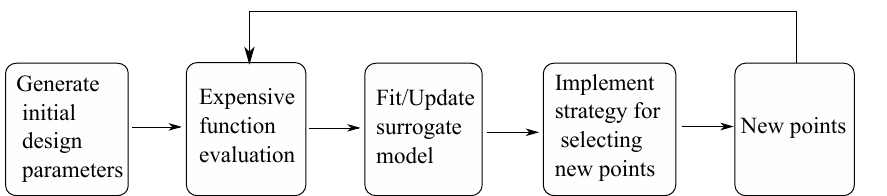
Figure 3. Flow chart of an expensive black-box optimization algorithm with surrogate model. Adopted and generalized from